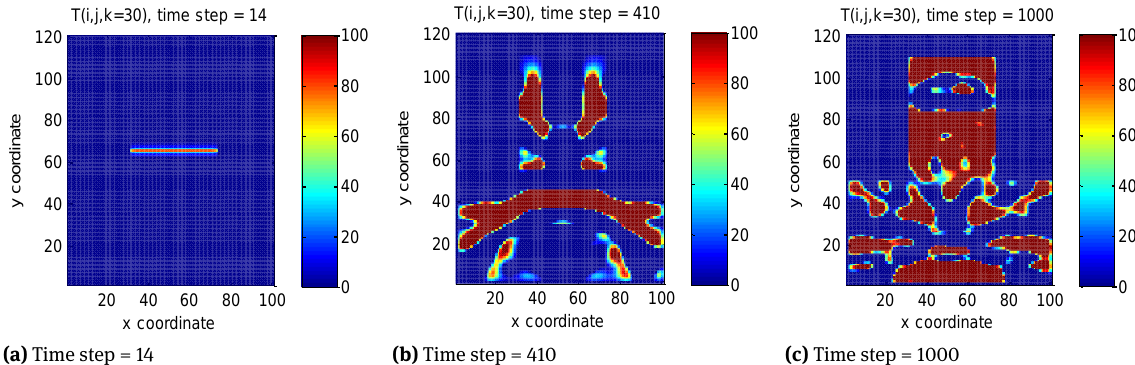
Figure 10: Temperature field distribution with material in cavity at different time step